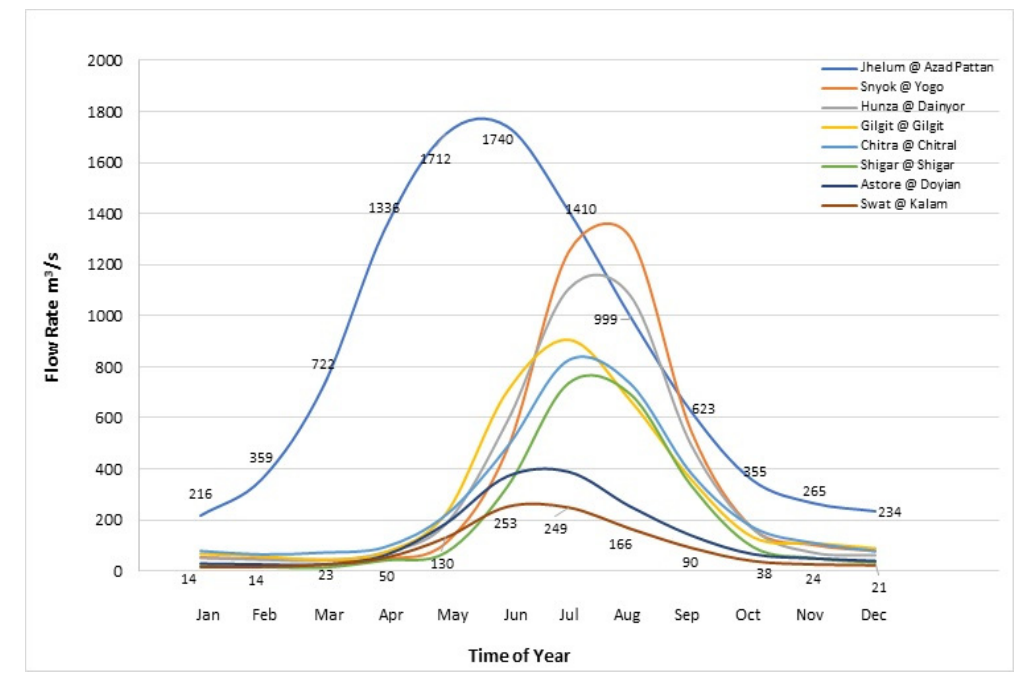
Figure 2. Flowrates of water channels in the region [5]. Table 1. Flowrates (m 3 /s) of rivers and streams in the